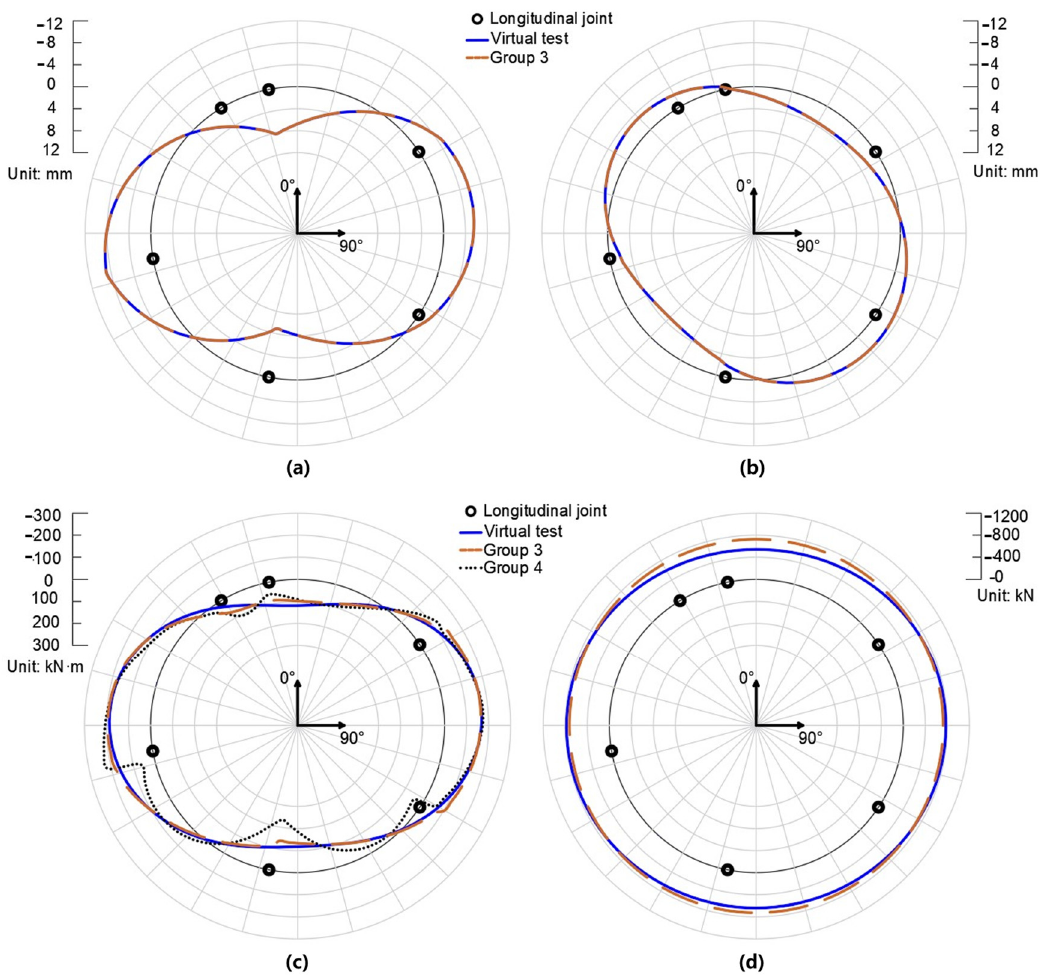
Figure 7. The radial displacement ( a ), tangential displacement ( b ), bending moment ( c ), and axial force ( d ) obtained by the hybrid analysis and remedial solution I at the condition that the measurement precision is 0.1 mm.